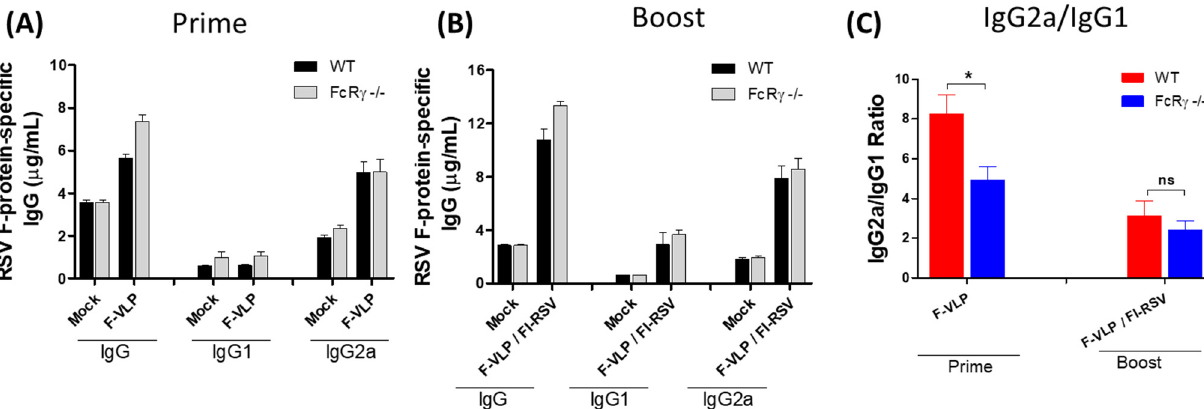
Figure 1. Antibody responses specific for respiratory syncytial virus (RSV)-F proteins in the serum of wild-type (WT) and Fc-receptor- γ -deficient (FcR γ − / − ) mice. FcR γ − / − mice ( n = 5 per group) and WT BALB/c mice ( n = 5) were intramuscularly (i.m.) immunized at week 0 (virus-like particle vaccine containing RSV-F protein (F-VLP) prime) and 4 (formalin-inactivated RSV (FI-RSV) boost). ( A ) F-specific IgG and isotypes after the prime. ( B ) F-specific IgG and isotypes after the boost. ( C ) Ratios of IgG2a to IgG1 isotype antibodies. F-VLP: RSV F-VLP (10 µg). F-VLP/FI-RSV: heterologous F-VLP prime and FI-RSV (2 µg + alum adjuvant 20 µg) boost. Statistical analysis is as follows. Results are presented as mean ± SEM. * p < 0.05. n.s.: not significant.